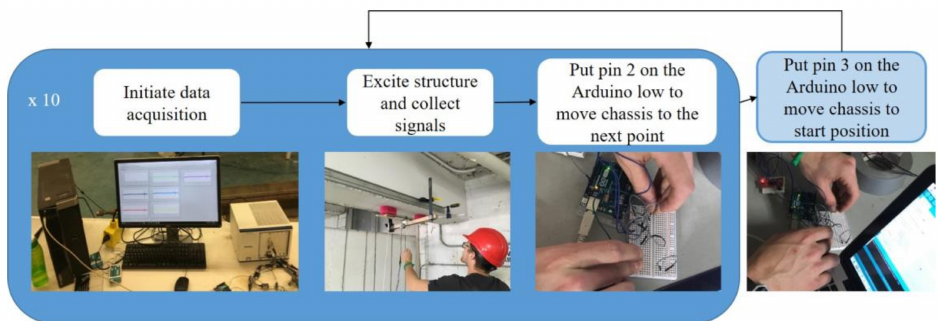
Figure 5. Automated test setup.